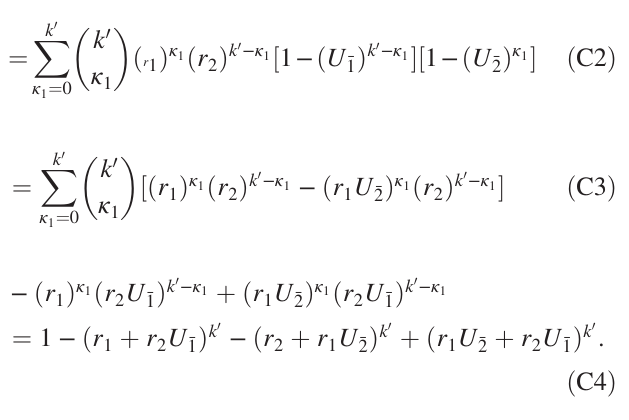
FIG. 11. For calculating the probability of a node with k links to belong to L that this node might show. First, B is the probability that, out of the k links, k 0 connect to the giant component. It is calculated using u k;k 0 (compare the left side of Fig. 9). Second, M gives the probability for a certain color distribution among the links. It is calculated using k 0 ;~ κ r , etc. (compare Fig. 9, second from left). We assume that this second step is independent of the first step, which is confirmed with the g final results. Third, P gives the joint probability that for this color distribution, L ¯ ~ κ calculated using U ¯ , etc. (compare the right side of Fig. r